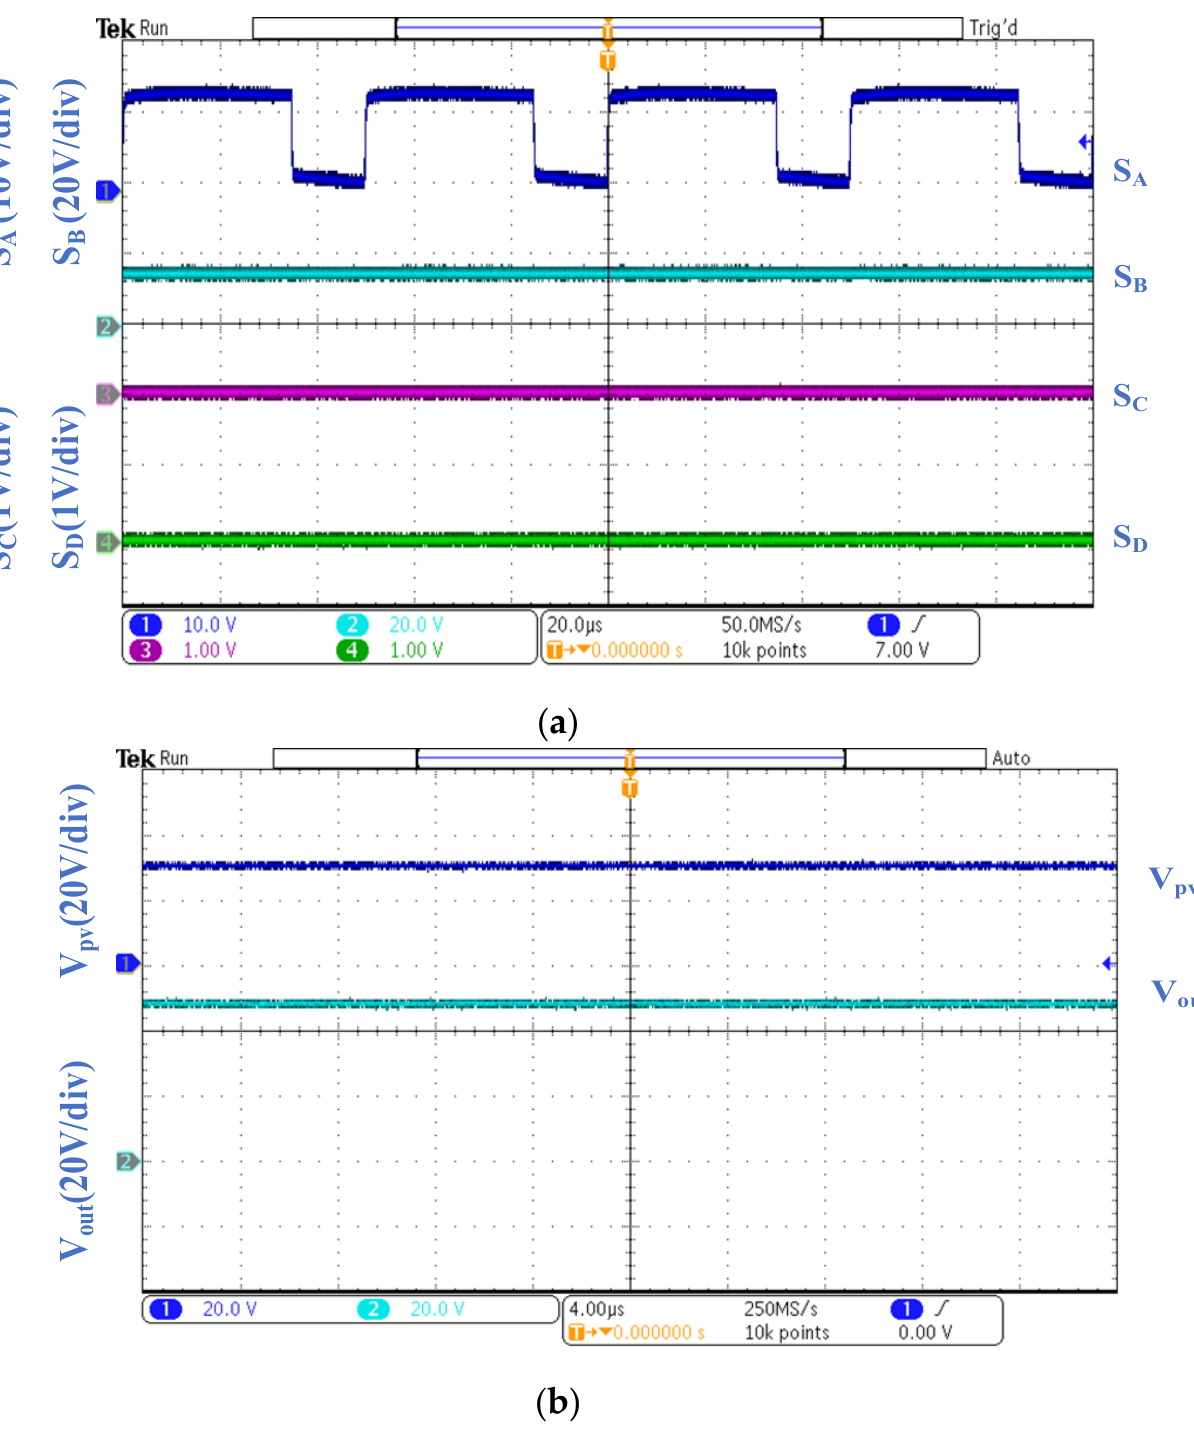
Figure 11. Experimental waveforms of the proposed IIABB converter for V pv of 30 V and N = 1: ( a ) experimental waveforms of switches S A and S B that are operating; S C and S D are not operating; and ( b ) waveforms of V pv = 30 V and output voltage V out = 48 V via an intelligent control strategy at a duty cycle of 0.62.